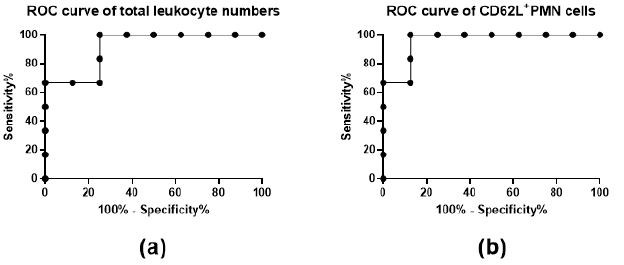
Figure 3. Receiver Operator Characteristic (ROC) curve analysis of ( a ) total leukocyte and ( b ) CD62L + PMN cell numbers to LFN-R and LFN-NR individuals. Samples were obtained from patients recently diagnosed with rheumatoid arthritis following three-month treatment with leflunomide (LFN; 20 mg/day, per os) (LFN group; n = 8; LFN-NR group; n = 6). CD62L